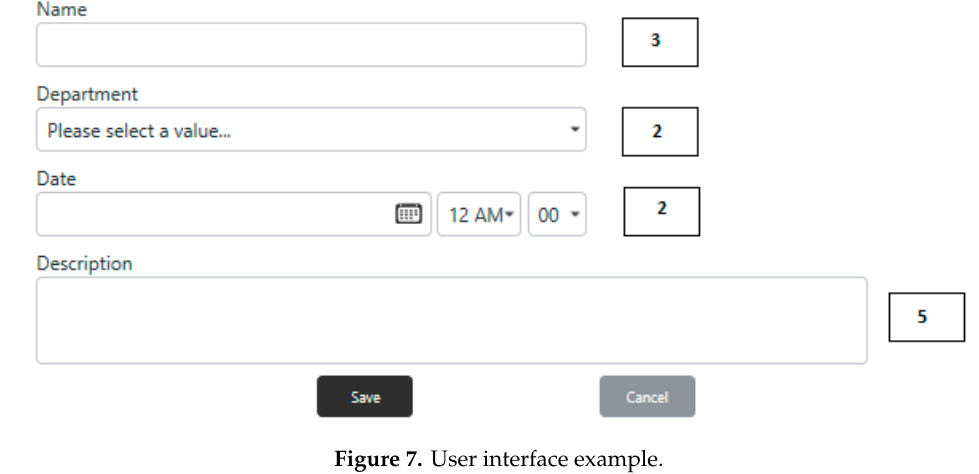
Figure 7. User interface example.